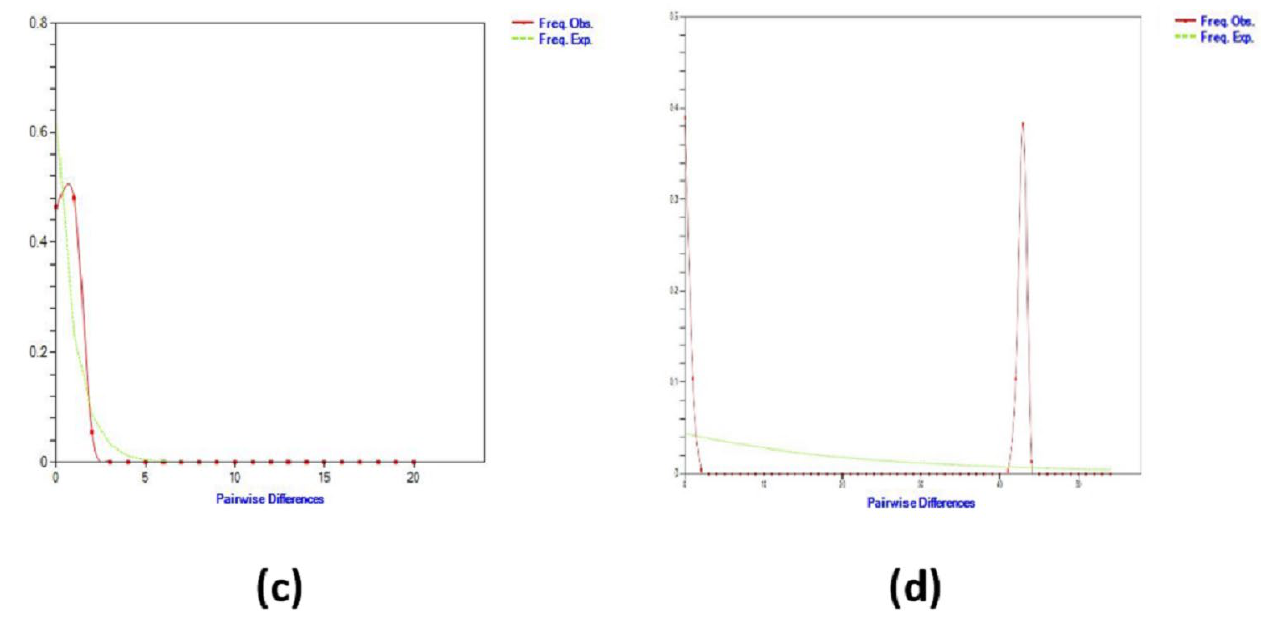
Figure 3. Mismatch distribution graphs of Batagur affinis for the ( a ) Pasir Gajah, Kemaman (KE), Terengganu ( b ) Bukit Pinang (BP), Kedah ( c ) Bota Kanan (BK), Perak, and ( d ) total populations.